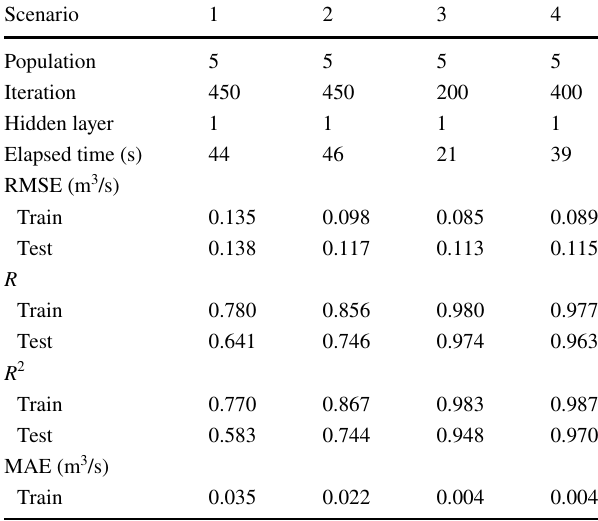
Table 4 Simulations of hybrid BA-ANN forecasting model in